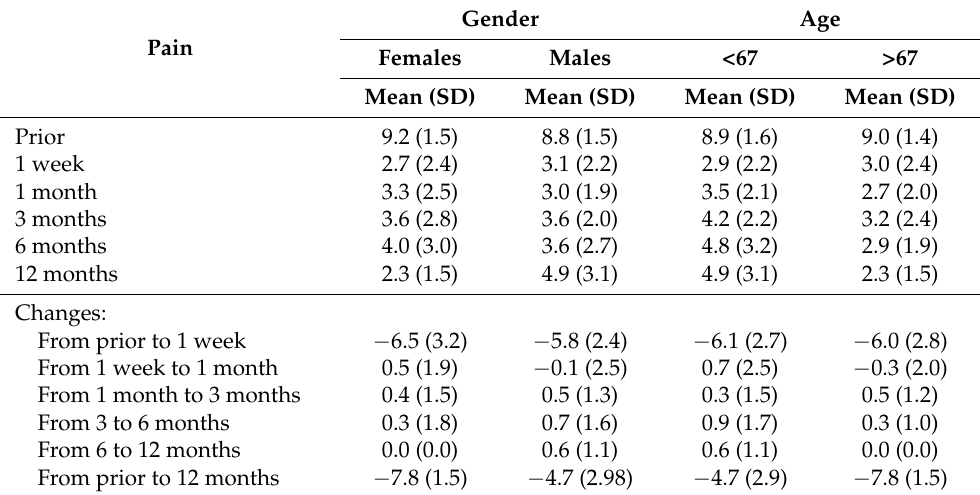
Table 3. Participants’ pain levels throughout follow-up, by gender and age